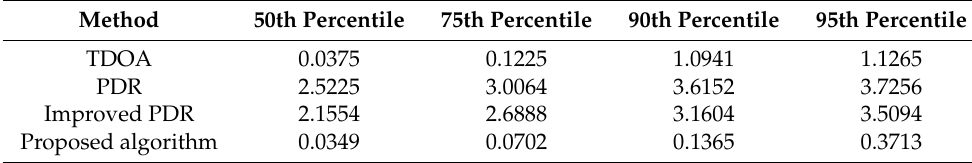
Table 5. Comparison of quantiles of error with different algorithms (m) (First scene).